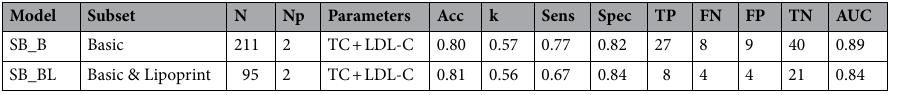
Table 3. Performance of models trained with SB criteria parameters. Column names as defined in Table 2